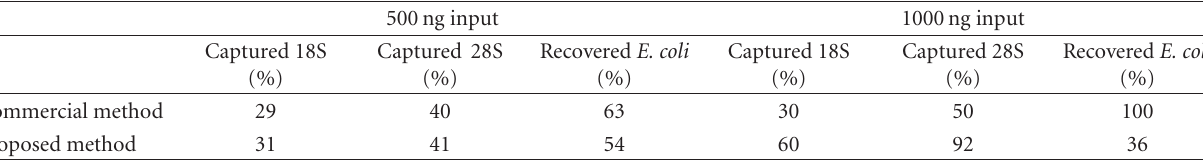
Table 4: Comparison of subtraction e ffi ciencies between the single-step and the two-step method using a commercially available enrichment kit (MICROB Enrich ,